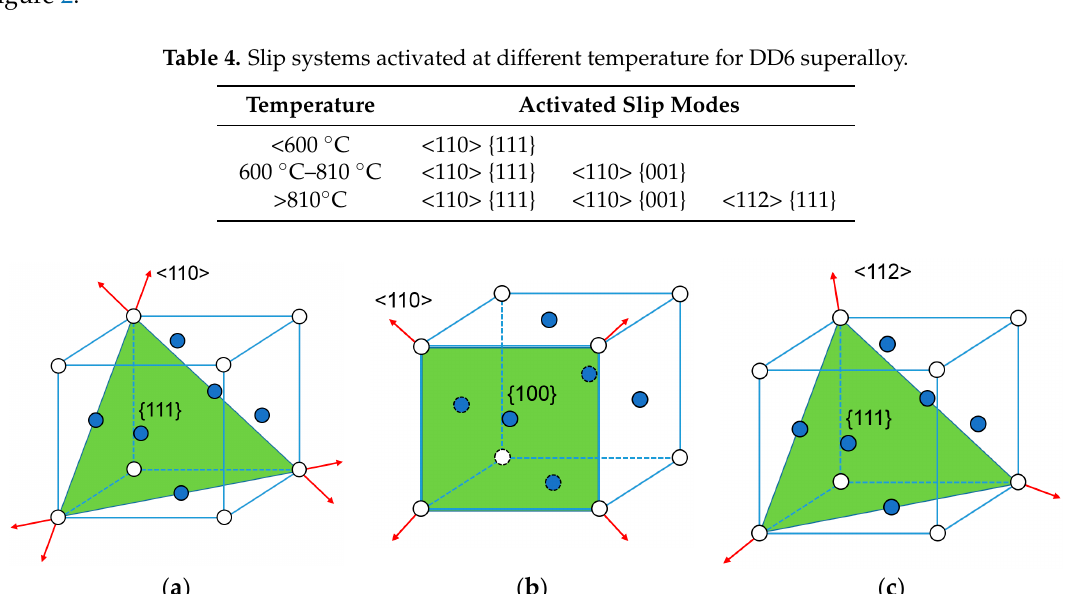
7 of 20 Figure 1. Deformation behavior of [001] orientated single-crystal samples: ( a ) stress-strain curves for the quasi-static compression at different temperature; ( b ) corresponding yield stress curve. The temperature dependence of deformation mechanisms in SX Ni-base alloys has been investigated through experiments [28,35,36] . Plastic deformation at ambient temperature occurs in face-centered cubic (FCC) metals mainly through the activated slip system consisting of <110> and {111}. When temperature increases to 800 °C, slip-line analysis in a deformed SX superalloy has revealed that the mode of slip deformation changes from α /2 <110> {111} to α /2 <110> {001} [1] . Reference [37] indicates that the slip modes activated at different temperature can be divided into